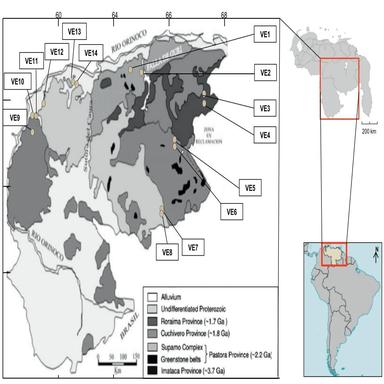
Geology and location of the studied samples.